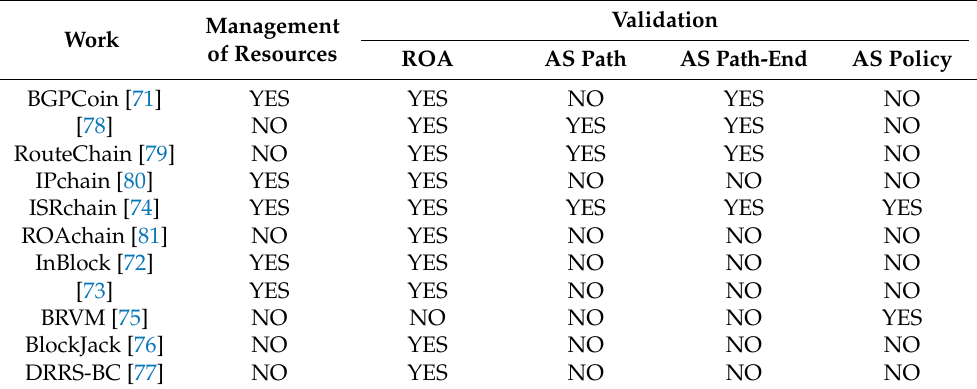
Table 4. Comparison of analysed papers with inter-domain security using